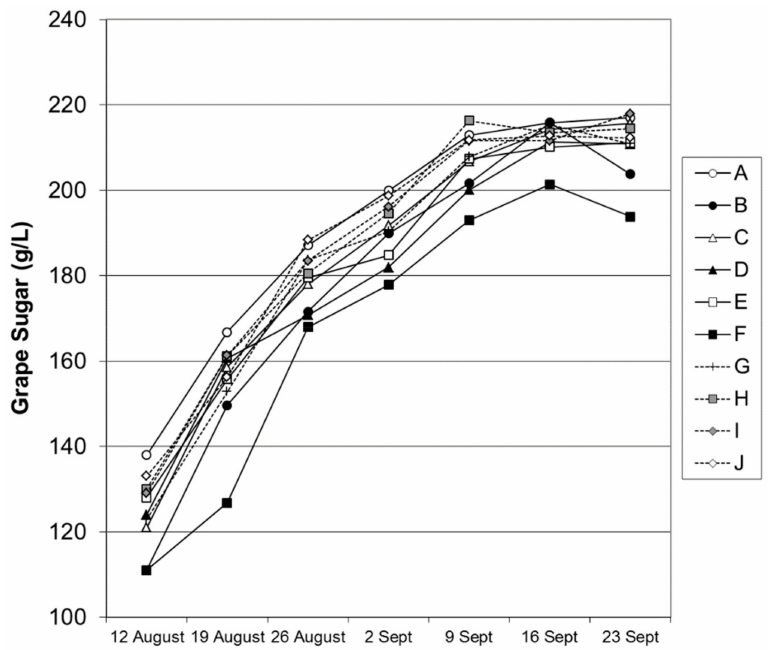
Figure 8. Sugar accumulation dynamics in 2013 from a private clonal selection program on Cabernet franc. A–J represent 10 di ff erent clones